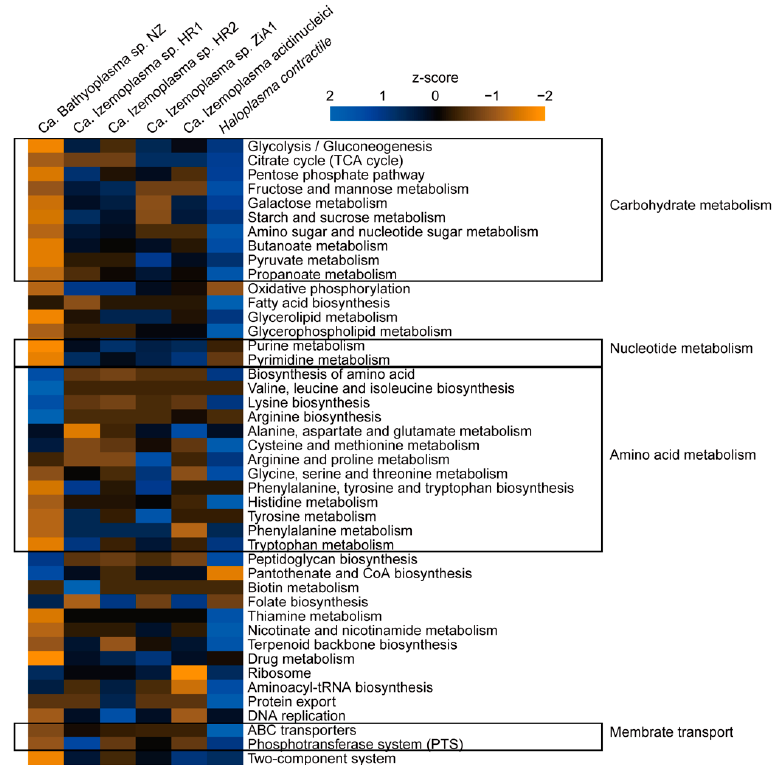
Figure 3. Comparison of gene numbers in different metabolic pathways. Gene numbers in each Kyoto Encyclopedia of Genes and Genomes (KEGG) pathway of BNZ and reference genomes are counted and normalized using z-score. Heatmap is generated using R.